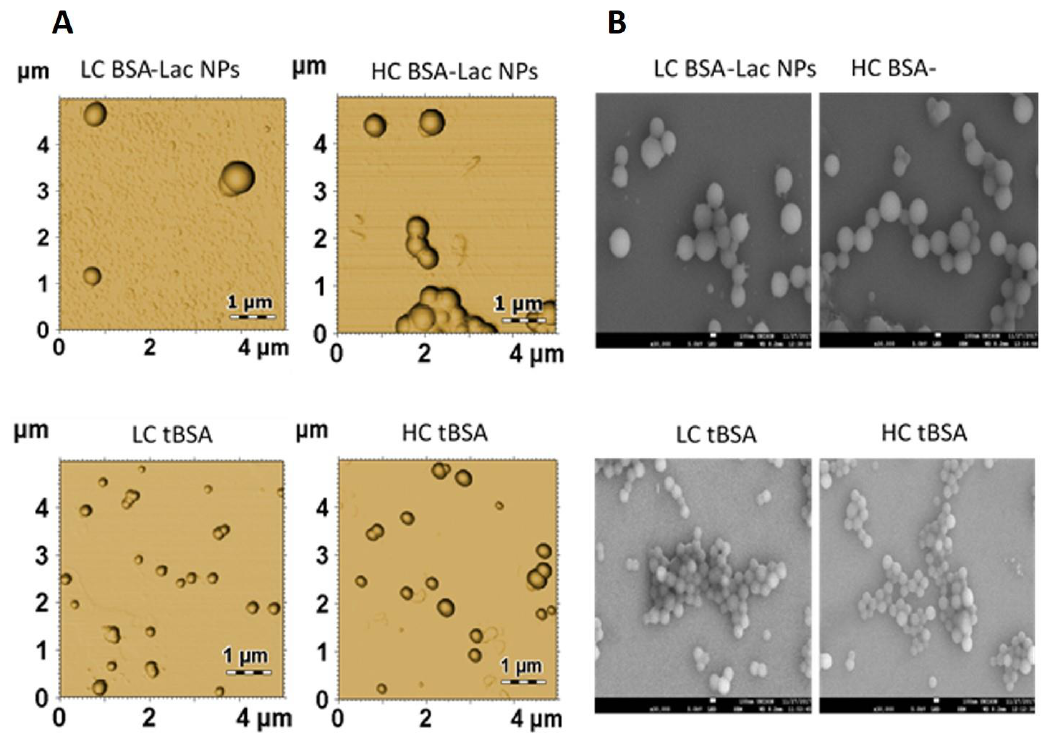
Figure 4. Analysis of nanoparticle morphology by ( A ) atomic force microscopy (AFM), and ( B ) scanning electron microscopy .